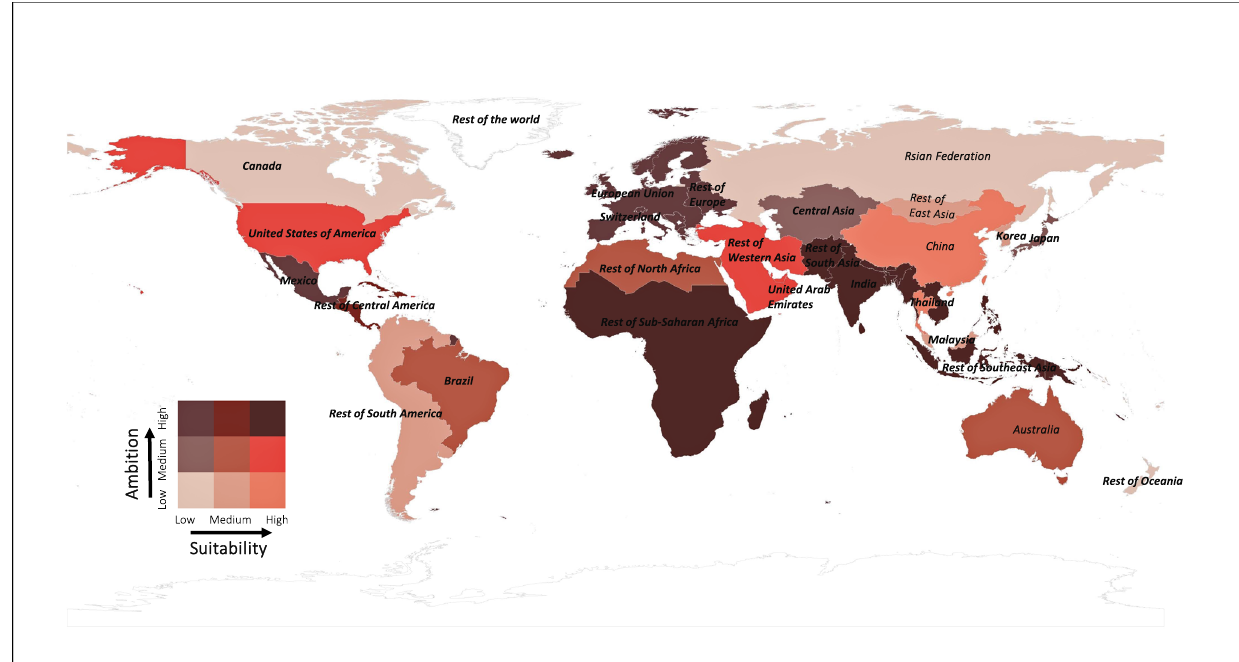
Fig. 1 Contrasting suitability and ambition of carbon mitigation among 27 emitting countries and regions. The RSM (relative suitability of mitigation) and NDC (national determined contribution) ambition for each region under SSP2-RCP4.5. For both RSM and ambition scores, “ High ” represents the top 1/ 3 among the 27 regions, “ Medium ” represents the middle 1/3, and “ Low ” represents the bottom